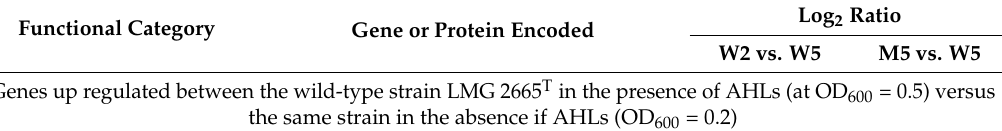
Table 3. Genes regulated by the EanI/R quorum sensing system in P. ananatis LMG 2665 T . Genes were identified by pairwise comparison between wild-type at OD 600 = 0.2 (no QS) and wild type at OD 600 = 0.5 (during QS) (W2 versus W5) and pairwise comparison of the wild-type at OD 600 = 0.5 and QS mutant at OD 600 = 0.5 (M5 versus W5).